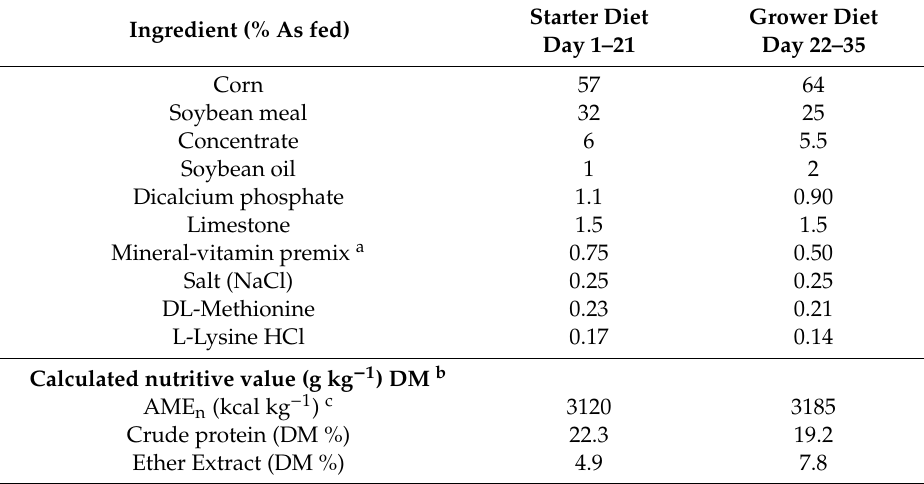
Table 1. Composition of the experimental